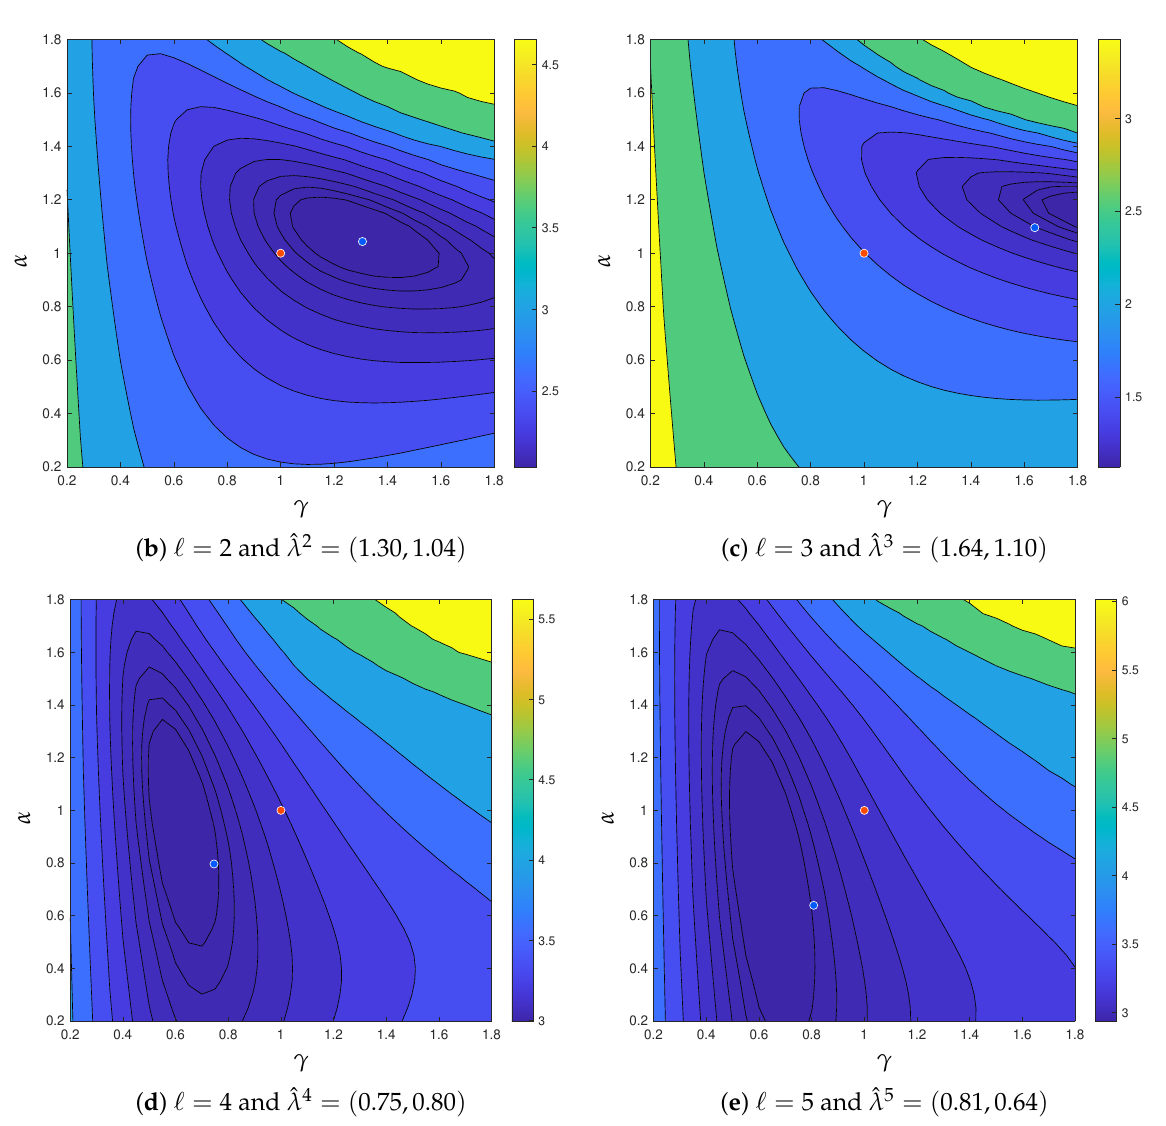
Figure 11. Contour map of evaluation function values D ( (cid:96) , z ( K )) with projection y (cid:96) for parameters γ , α . Blue and red points indicate ˆ λ (cid:96) and ( 1,1 ) corresponding to the MLEM algorithm,